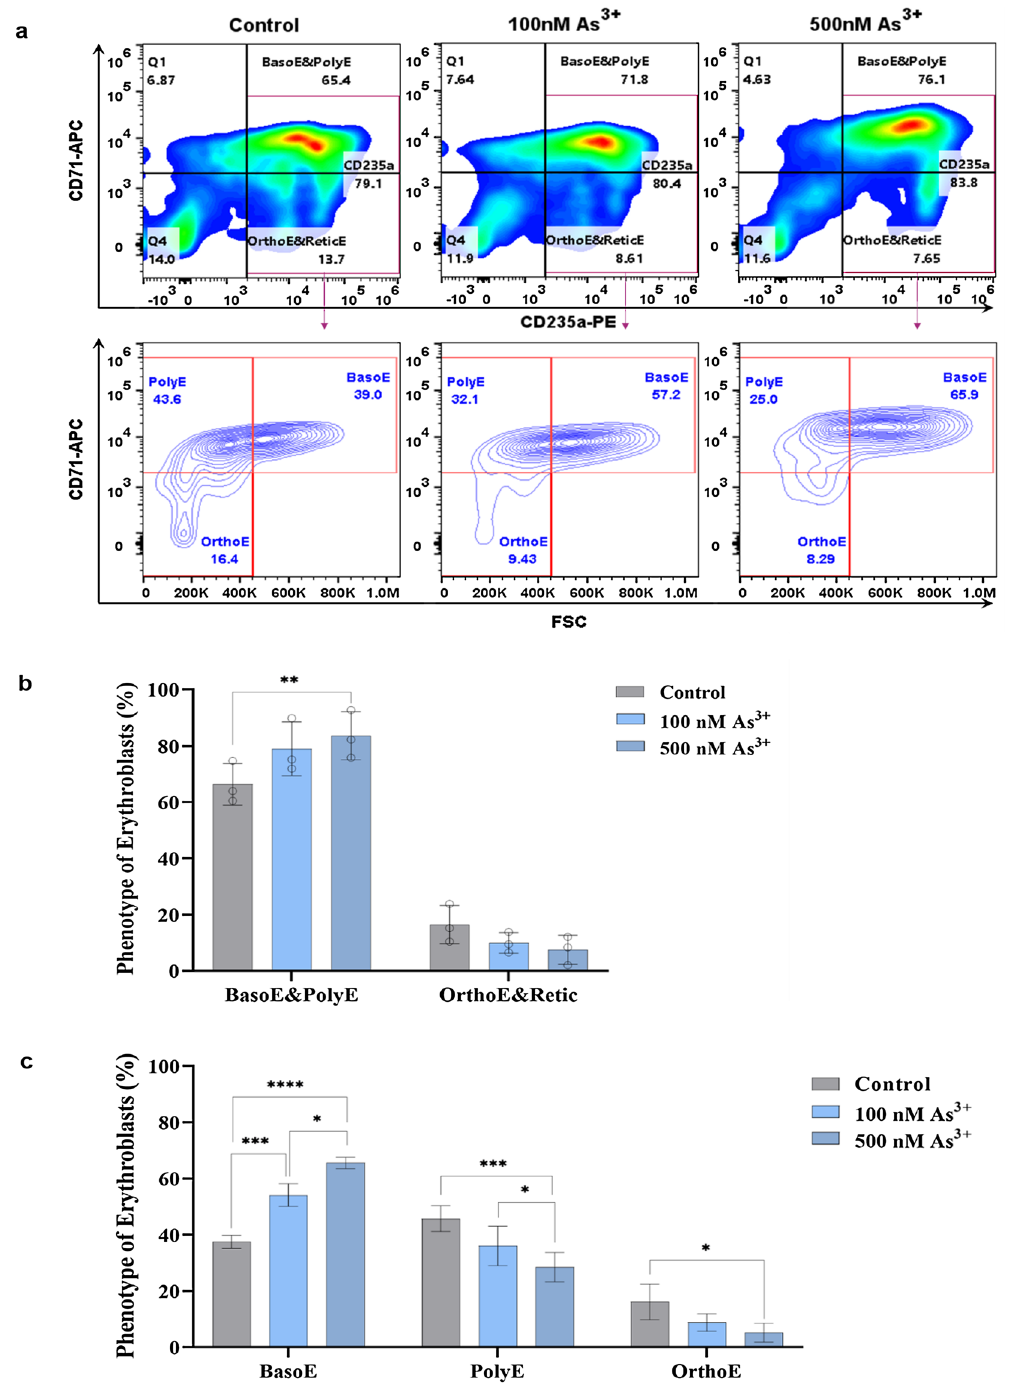
Figure 4. As 3+ exposure impairs erythroblast differentiation and maturation (on day 19 ± 1). CD34 + -HPCs (1 × 10 4 cells/ ml) were cultured for 19 (± 1) days in erythroid expansion medium in the presence of 0, 100 nM, or 500 nM As 3+ . Cells were labeled with APC-conjugated antibody against CD71 (CD71-APC) and PE-conjugated antibody against CD235a (CD235a-PE) and were analyzed by flow cytometry. ( a ) Identification of erythroblasts phenotypes were performed using two gating strategies. One is based on the plot of CD235a versus CD71 (Top-panel). Cells were distinguished as distinct subpopulations BasoE/PolyE, and OrthoE/ReticE. The second is based on plot of CD235a + cells using CD71-APC versus FSC-A (Bottom-panel). By this method, CD235a + cells on the top-panel can be further separated as 3 subsets: BasoE, PolyE and OrchoE. ( b ) As 3+ exposure increases the population of less mature erythroblasts (BasoE/PolyE) and decreases the number of more mature erythroblasts (OrthoE/ReticE) on Day 19 ± 1 of the erythroid expansion of human CD34 + cells. ( c ) As 3+ exposure increases the population of less mature erythroblasts, BasoE and decreases the number of more mature erythroblasts, OrthoE. Data are expressed as mean ± SD, n = 3 replicates/group, *( p < 0.05), **( p < 0.01), ***( p < 0.001), and ****( p < 0.0001) in one-way ANOVA, followed by Tukey’s post hoc test between the